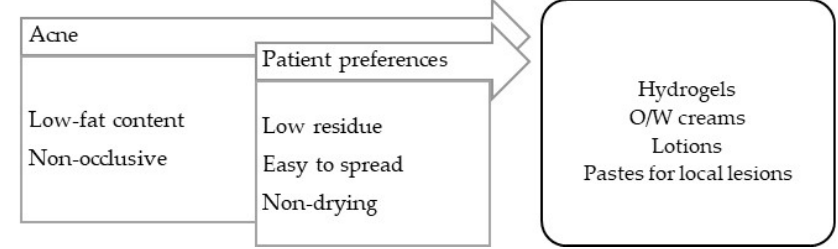
Figure 6. TPP for formulations for acne treatment and most suitable vehicles/bases.